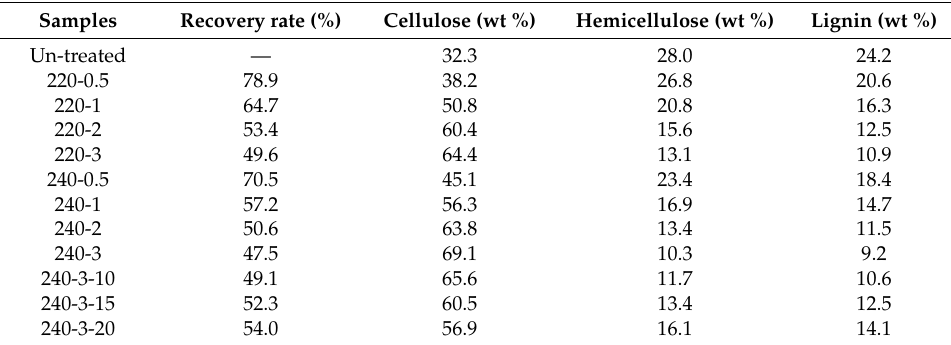
Table 2. Recovery rate and chemical composition of glycerol pretreated corncobs.